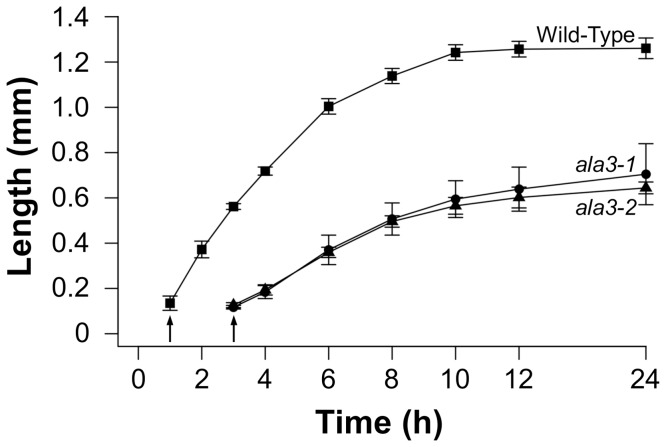

In-vitro assays show ala3 pollen tubes have delayed emergence, slow growth and shorter overall length.Pollen was placed on pistils, either from the corresponding genotype or from surrogate ms-1 plants, and the pistils were placed on pollen tube growth media. Pollen tubes growing out of the pistils were measured over a 24 h time course. Arrows represent time when buds were first observed. Lengths were reported for each time point as the average length of the 10 longest pollen tubes. Values and error bars represent the mean ± SE of three independent experiments for wild-type and ala3-1, and two independent experiments for ala3-2.